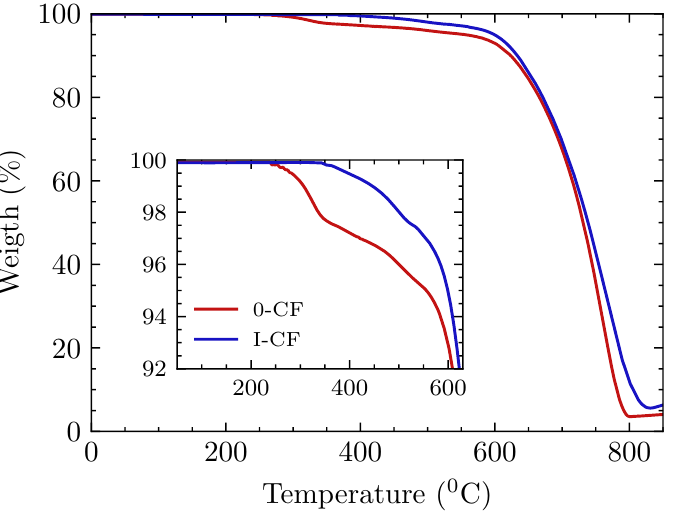
Figure 8. TGA analysis of untreated carbon fibre ( 0-CFs ) and treated ones ( I-CFs ). Inset: untreated specimens underwent weight loss from 280 ◦ C onwards due to sizing decomposition